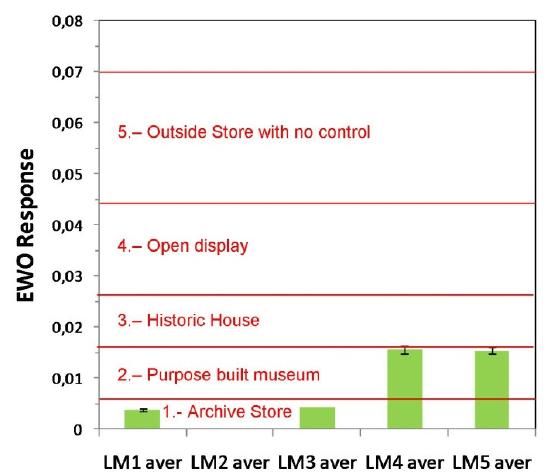
Fig. 2. EWO dosimeter responses (∆Light absorbance) obtained in the five indoor locations in the LTMCM